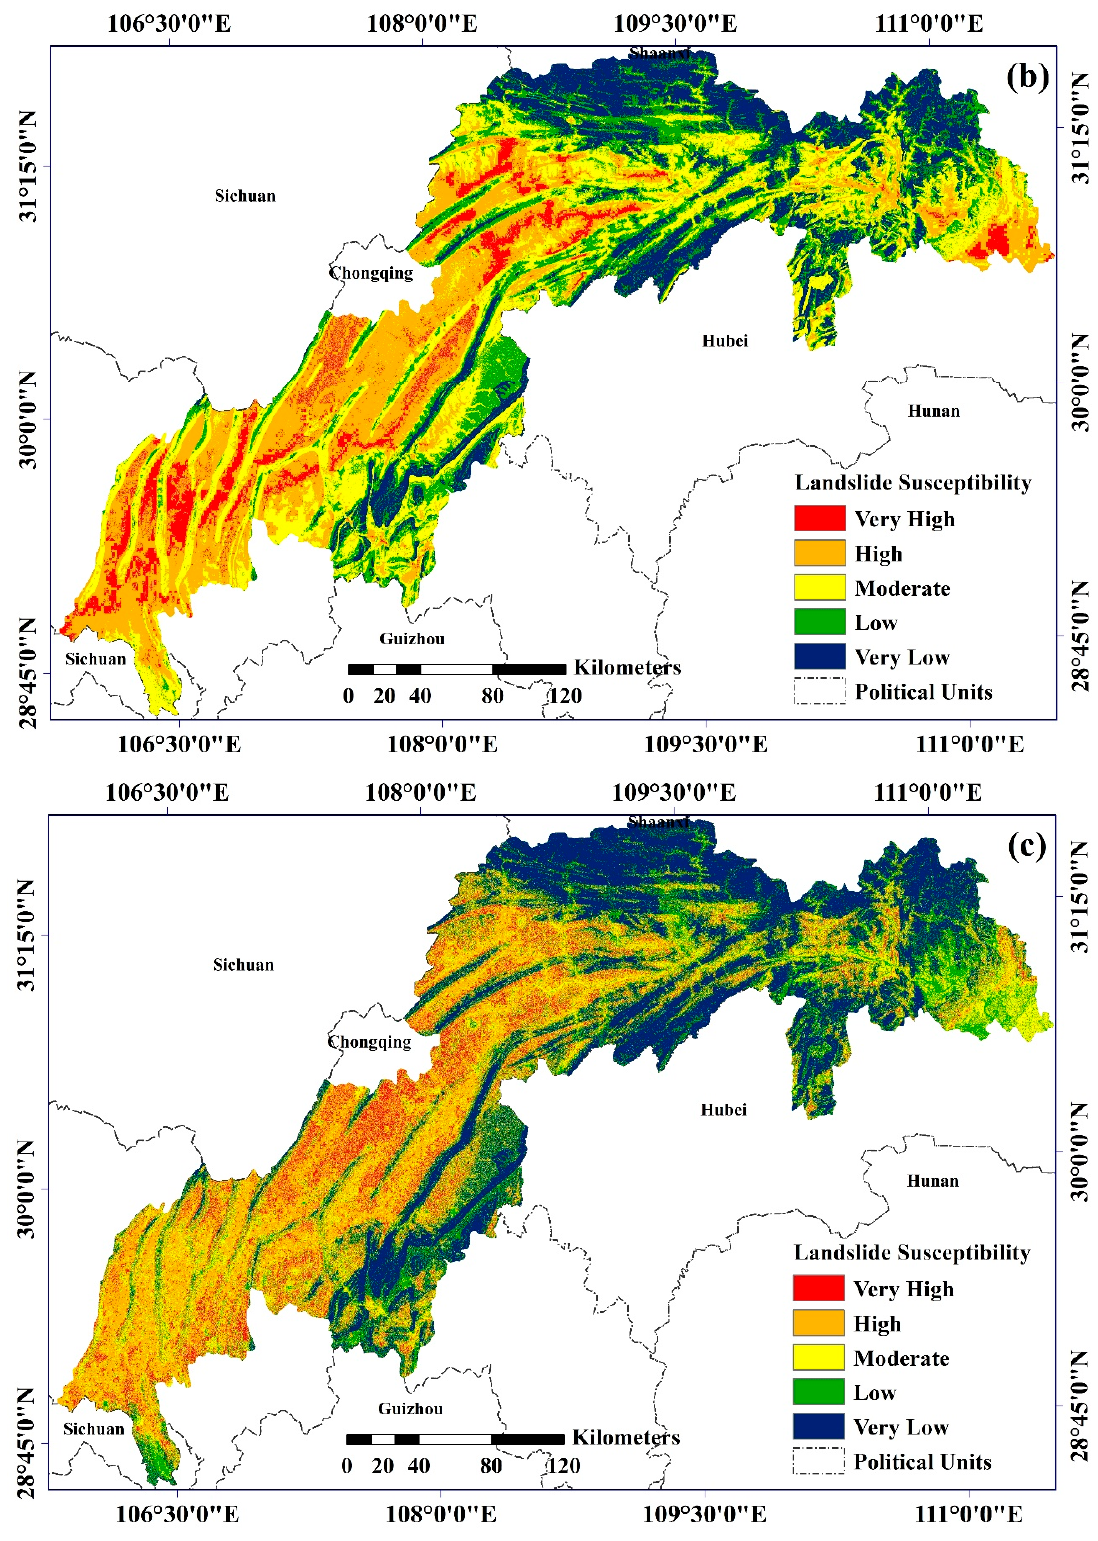
Figure 7. Assessment of landslide susceptibility: ( a ) Logistic regression; ( b ) random forest; ( c ) support vector machine.